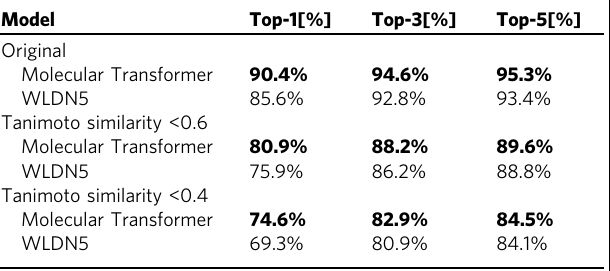
The performance of the best ML models on various USPTO train/test splits are shown. The accuracy of the best-performing model is highlighted in